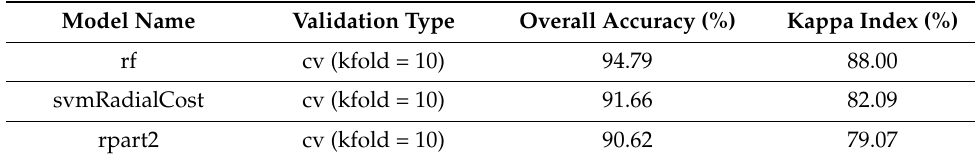
Table 1. Accuracy of ten-fold cross-validation (cv) for all tested models.